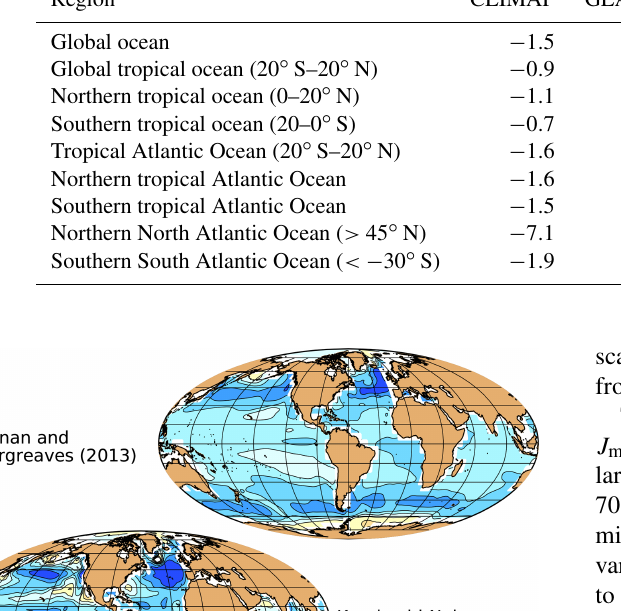
Table 4. Comparison of global gridded climatologies of the ocean surface during the LGM in terms of the area-weighted regional anoma- lies of the annual-mean NSST (CLIMAP: CLIMAP Project Members (1981); GLAMAP: Sarnthein et al. (2003a); AH2013: Annan and Hargreaves (2013); K2017: Kurahashi-Nakamura et al. (2017); T2020: Tierney et al. (2020); GLOMAP: this study). Region CLIMAP GLAMAP